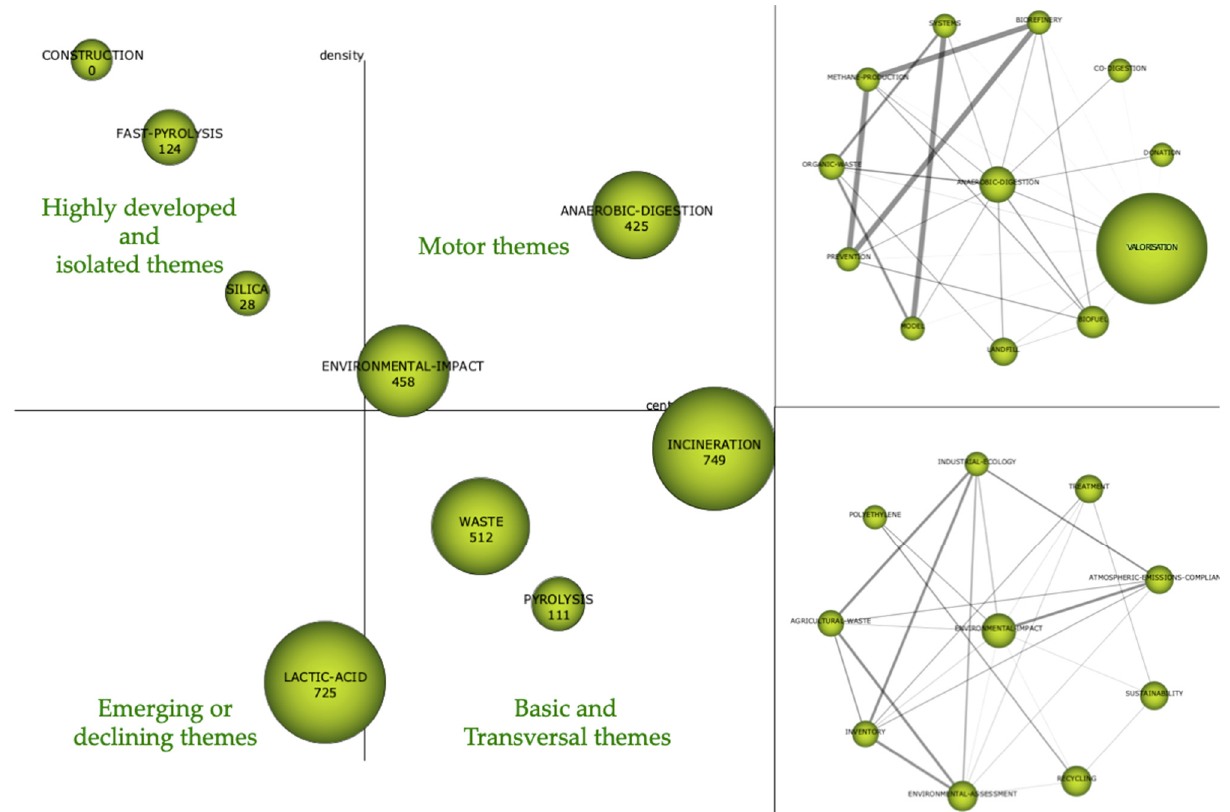
Figure 10. Strategic diagram and main thematic network, 2011–2015 period.